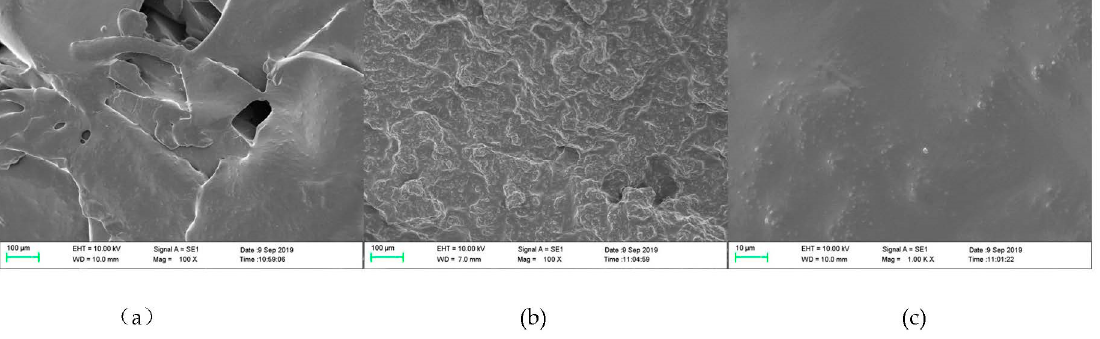
Figure 5. PUF ( a ), BBS modified PUF magnified 100 times ( b ), BBS modified PUF magnified 1000 times ( c ).